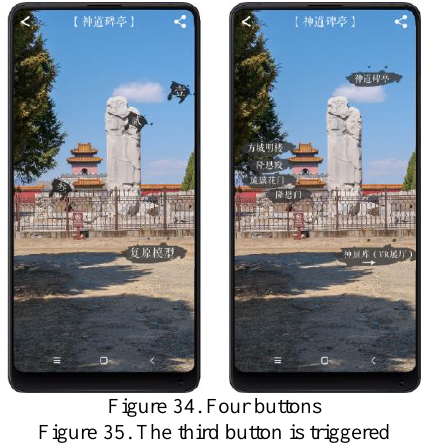
Figure 35. The third button is triggered